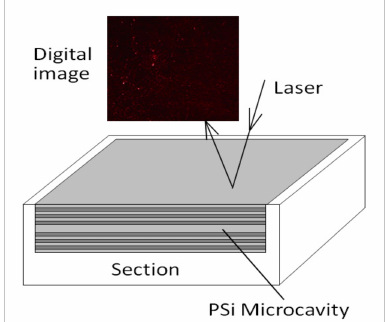
Figure 9. Digital image of light reflected from the surface of a PSi microcavity.